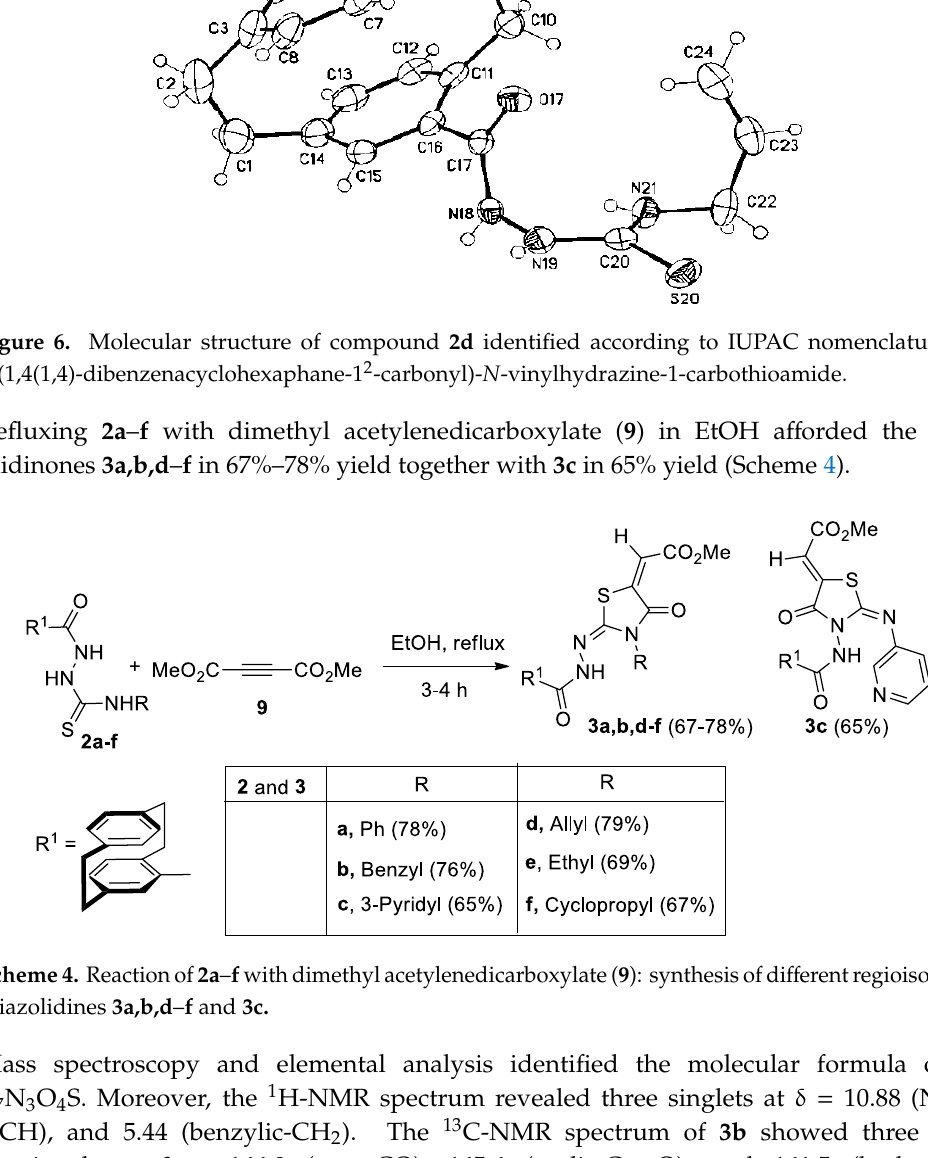
Figure 5. Molecular structure of compound 2b identified according to IUPAC nomenclature as 2-